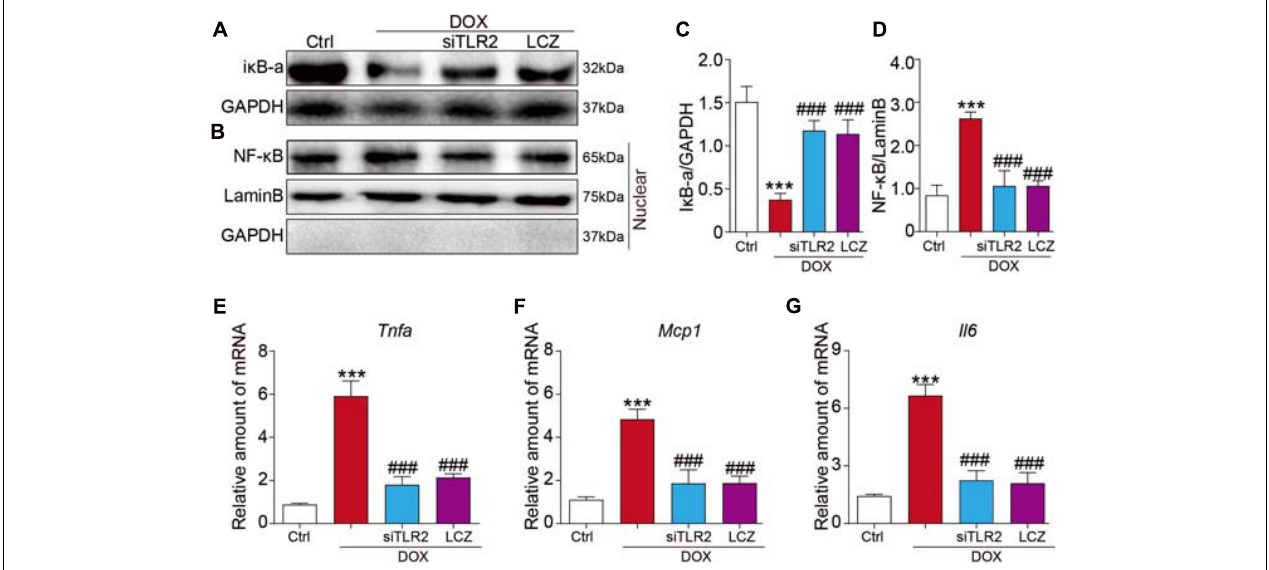
FIGURE 5 | LCZ696 treatment and TLR2 knockdown attenuated the doxorubicin-induced H9C2 cell inflammatory response in vitro . (A,B) H9C2 cells were transfected with control siRNA, TLR2 siRNA, and LCZ696 (20 µ mol/l) and then stimulated with DOX (1 µ M) for 8 h. Western blot detected I κ Ba and GAPDH protein levels in whole cell lysates (A) and detected NF- κ B, Lamin B, and GAPDH protein levels in the nuclear extractions (B) . (C) Densitometric quantification of I κ Ba/GAPDH levels in the immunoblots presented in panel (A) . (D) Densitometric quantification of NF- κ B/Lamin B levels in the immunoblots presented in panel (B) . (E–G) The mRNA levels of Tnfa (E) , Mcp1 (F) , and Il-6 (G) were measured by real-time PCR. ( n = 5; *** P < 0.001 vs. Ctrl group; ### P < 0.001 vs. DOX